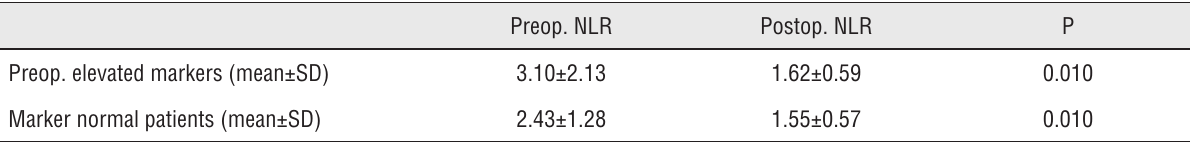
Table 4 - Neutrophil to lymphocyte ratio of patients with preoperative elevated tumor markers that normalized postoperatively and patients with normal tumor markers.